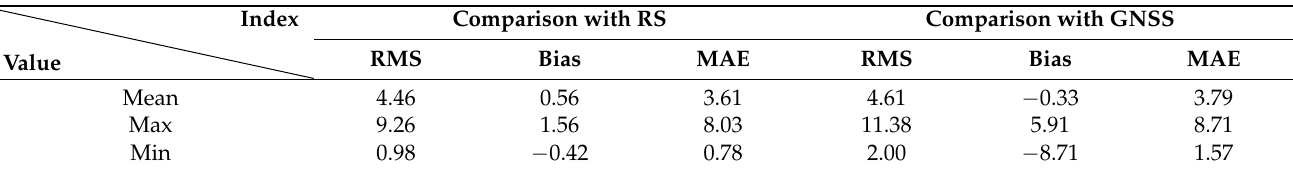
Table 4. Statistical results of RMS, Bias, MAE of PWV differences between FY3-A and GNSS (260)/RS (87), respectively, in China over the period of 2012 to